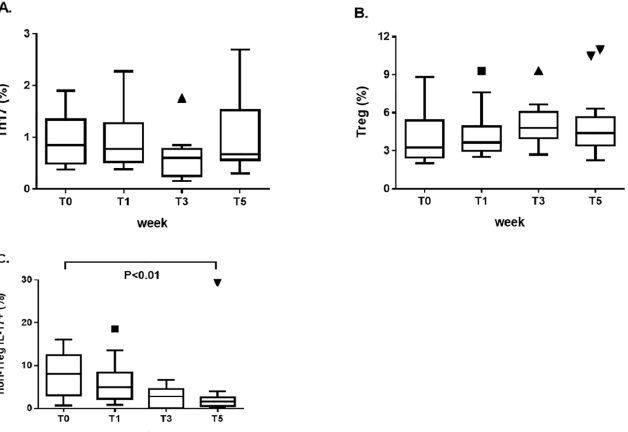
Fig 3. Change in the frequencies of Th17 and Treg cells (including the nTreg, eTreg, and non-Treg fractions) in the peripheral blood of patients with rheumatoid arthritis at the main timepoints of the study set at T0 (baseline, before starting the low-sodium dietary regimen), T1 (after 1 week, at the end of the “run-in” period of low-sodium dietary regimen), T3 (after 3 weeks, at the end of low-sodium dietary regimen), and T5 (at the end of the study, after 2 weeks of normal sodium dietary regimen). (A) No significantchange in the frequencies of Th17 cells betweenthe main timepointsof the study. (B) No significantchangein the frequenciesof Treg cells betweenthe main timepointsof the study. (C) The frequency of non-Tregfraction of Treg cells (exhibitingthe capability to trans-differentiate into Th17 cells and indeedbeing positive for the intracellular stainingwith IL-17 mAb) significantly decreased at the end of the study with respect to baseline.Data are shown as Tukey boxplots;lines represent the medianlevel with 25 th - 75 th percentile;data not includedbetweenthe whiskersare plotted as outliers with dots.